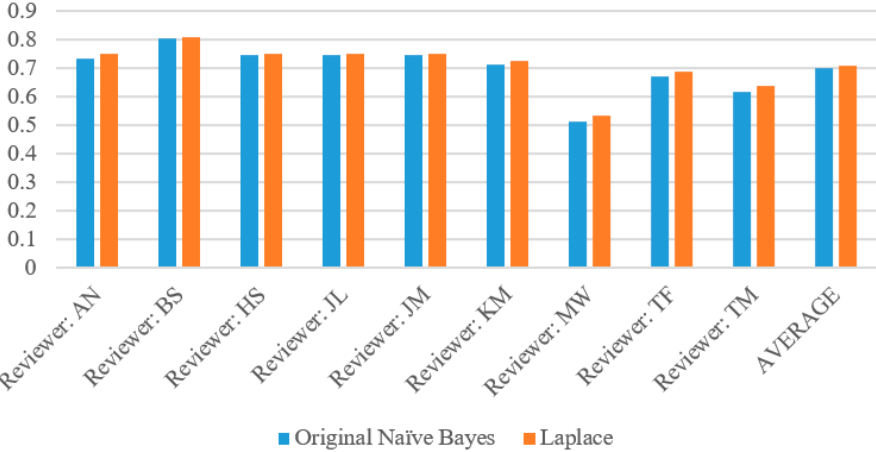
Figure 7. Recall for each reviewer with both original Naïve Bayes and Laplace.